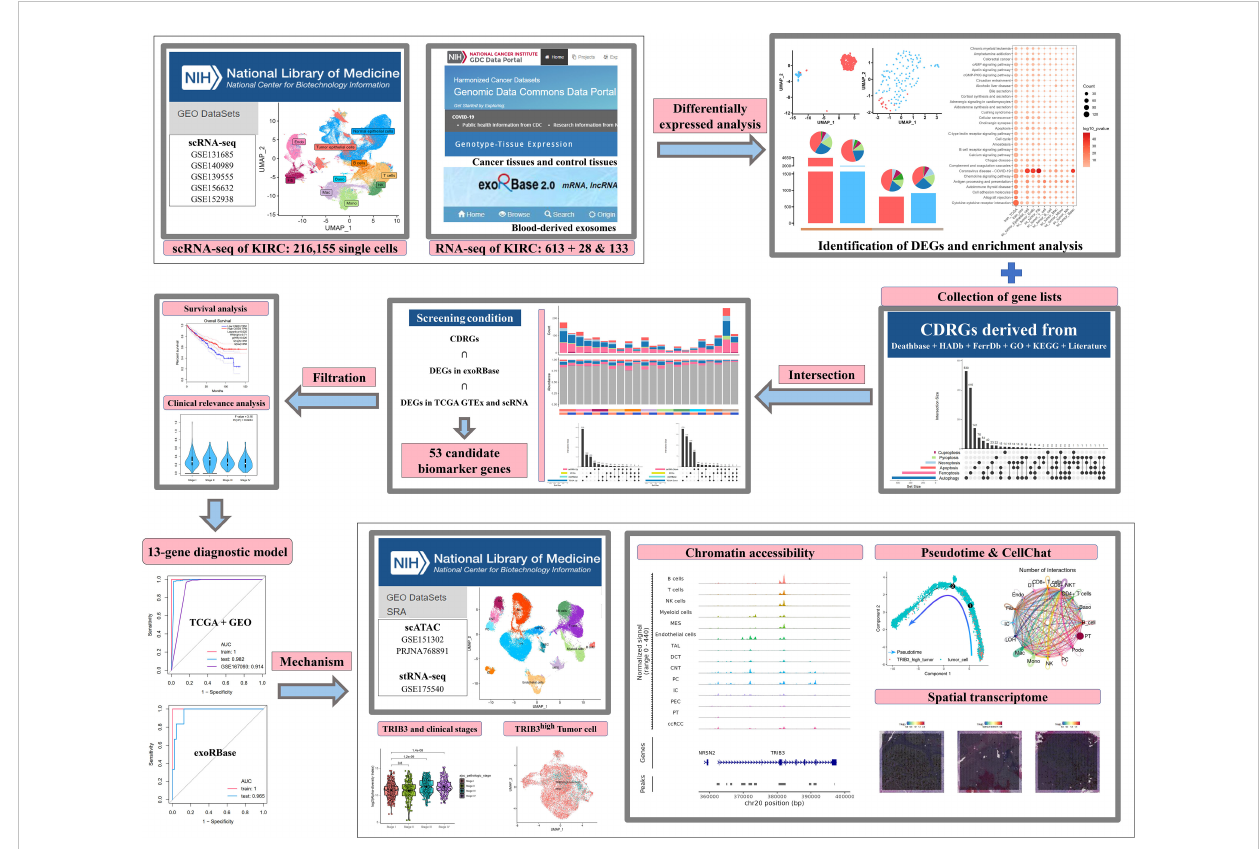
FIGURE 1 The dataset information and work fl ow of the presented